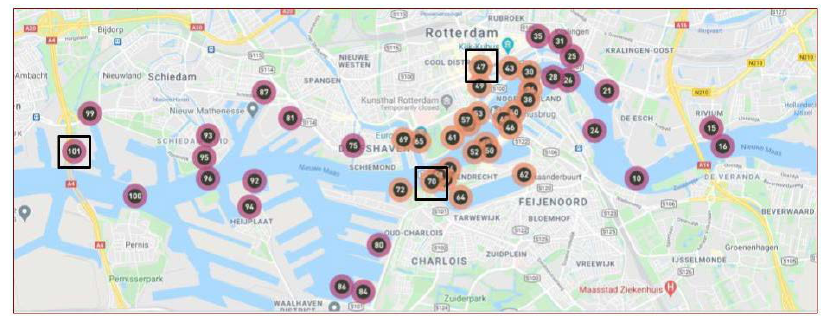
Figure 1: Water Taxi Rotterdam . Dock locations with recording spots highlighted in black: 47, 70, and 101. (https://www.watertaxirotterdam.nl/steigerlocaties).